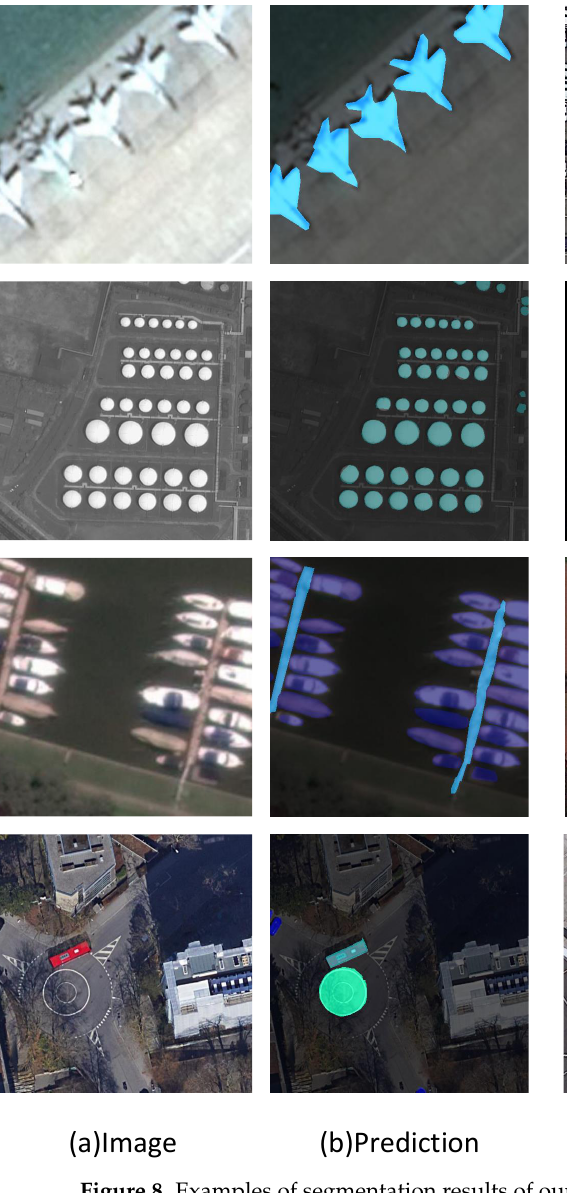
Figure 8. Examples of segmentation results of our method on iSAID. ( a ) Image. ( b ) Prediction. Threshold τ (cid:96) of low GradCAM D proposals D (cid:96) . Low GradCAM D proposals D (cid:96) depends on one key hyper-parameter, threshold τ (cid:96) . We use D (cid:96) as pseudo label to train segmentation model, which is vital to final performance. The threshold τ (cid:96) balances the foreground and background pixels within boxes annotations. If τ (cid:96) is set to 0, all pixels within boxes annotations are seen as proposals. As τ (cid:96) increases, the area of proposals decreases and only the distinguished part of GradCAM D remained in proposals. Table 3 shows the influence of threshold τ (cid:96) . As τ (cid:96) get higher, the area of foreground pixels get lower. Because foreground pixels usually take up most area within boxes annotations, so we find best τ (cid:96) in small values. When τ (cid:96) = 0.15, using D (cid:96) proposals as ground truth, we achieve the best performance. Table 1 indicate that D (cid:96) reachs 53.88% mIoU on iSAID validation set. We also fix τ (cid:96) = 0.15 in generating GrabCut C